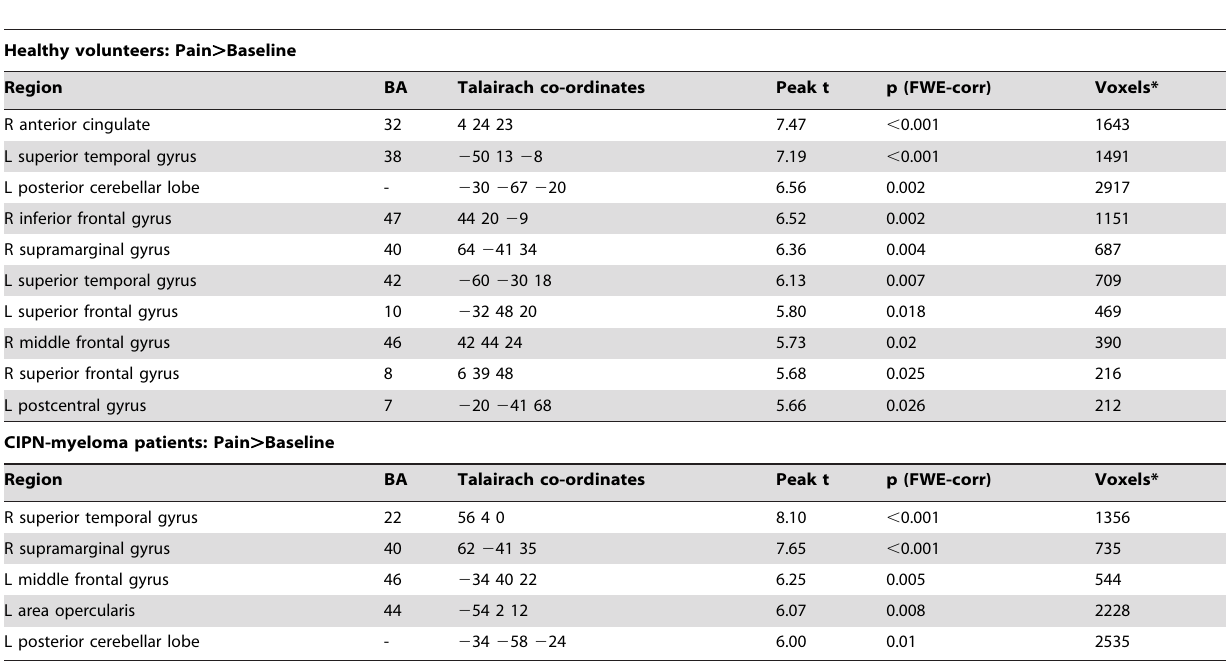
Table 3. Anatomical regions showing areas where statistical significant BOLD fMRI response to heat-pain stimuli were greater than baseline temperature for Healthy Volunteers and myeloma patients with CIPN.